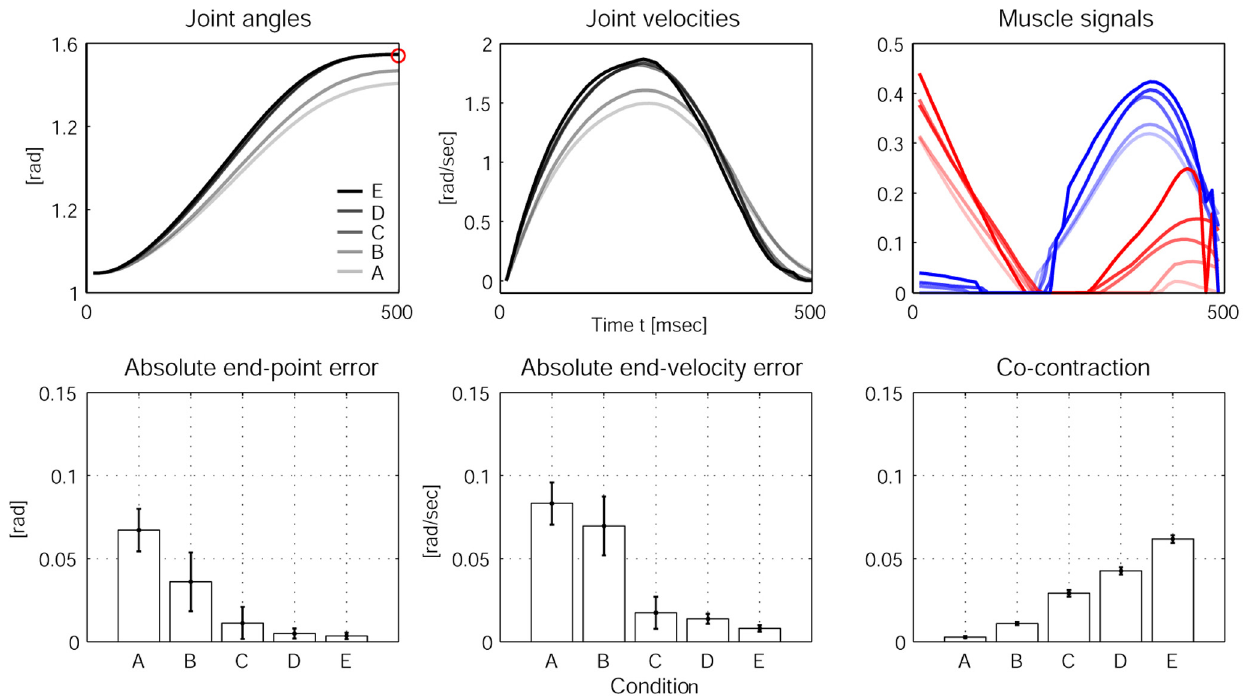
Figure 4. Experimental results from stochastic OFC-LD for different accuracy demands. The first row of plots shows the averaged joint angles (left), the averaged joint velocities (middle) and the averaged muscle signals (right) over 20 trials for the five conditions A, B, C, D, and E. The darkness of the lines indicates the level of accuracy; the brightest line indicates condition A, the darkest condition E. The bar plots in the second row average the reaching performance over 20 trials for each condition. Left: The absolute end-point error and the end-point variability in the trajectories decreases as accuracy demands are increased; Middle: End-point stability also increases (demonstrated by decreasing error in final velocities); Right: The averaged co-contraction integrated during 500 msec increases with higher accuracy demands, leading to the reciprocal relationship between accuracy and impedance control as observed in humans.